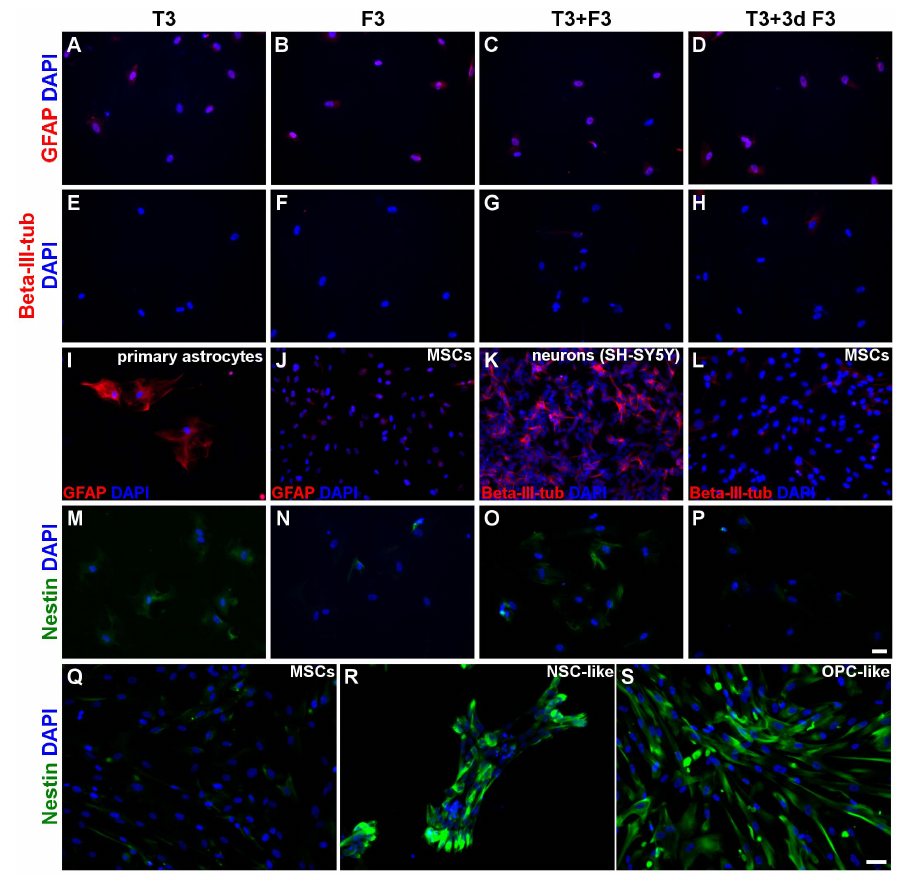
Figure 5. Expression of neural precursor, astrocytic and neuronal markers by OL-like cells. The expression of the astrocytic marker GFAP ( A-D and I-J ), the neuronal marker beta-III-tubulin ( E-H and K-L ) and the neural precursor marker nestin ( M-P and Q-S ) in OL-like cells derived from OPC- like cells cultured on fibronectin ( A-H and M-P ) was determined by immunofluorescence microscopy. OL-like cells were differentiated for 10 days on laminin-2 (merosin)-coated wells, in the presence of T3 (thyroid hormone), F3 (contactin), T3 + F3 or 7 days T3 followed by 3 days T3 + F3 (T3 + 3d F3), as indicated. It was evident that the neural precursor marker nestin decreased in the OL-like stage of differentiation ( M-P ), as compared to NSC- or OPC- like cells ( R and S, respectively ), indicating maturation of the OL-like cells. It was also clear that the astrocytic marker GFAP was present in rat astrocytes as expected ( I ), but essentially absent in OL-like cells ( A-D ) or hUCM-MSCs ( J ). Similarly, the neuronal marker beta-III-tubulin was detected in the neuronal cell line SH-SY5Y ( K ) but undetected in OL-like cells ( E-H ) or hUCM-MSCs ( L ). Counterstaining of nuclei was performed with DAPI (in blue) and the scale bars represent 50 m m - scale bar in image ( P ) is representative for images ( A-P ) and scale bar in image ( S ) is representative for images ( Q- S ). Images are representative of at least 3 independent experiments.